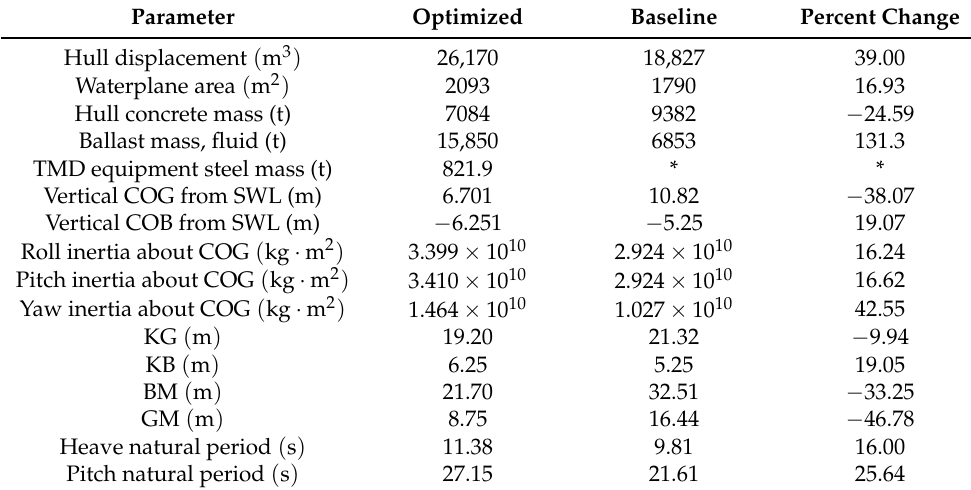
Table 22. Mass and hydrostatic properties for the optimized platform. Parameter Optimized Baseline Percent Change Hull displacement ( m 3 )